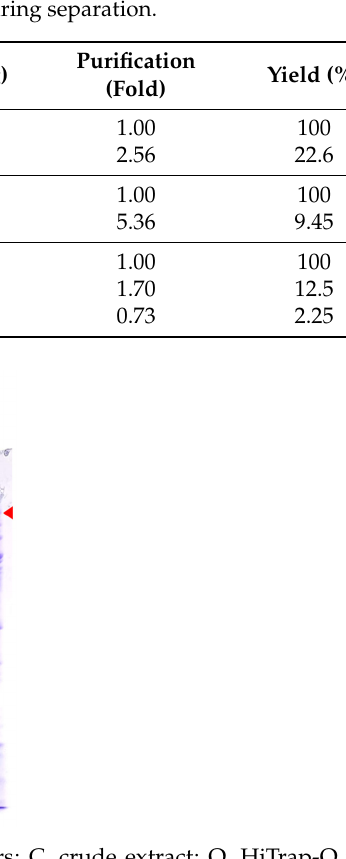
Table 2. Molecular masses of native Est2L and Est4L determined with Sephacryl S-200. Protein